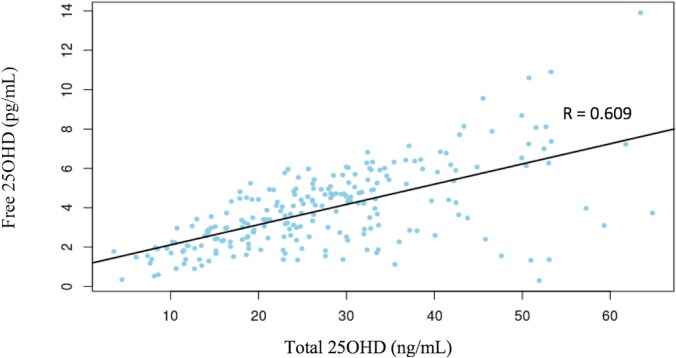
Significant (p < 0.001) positive correlation between serum free and total 25OHD concentrations.